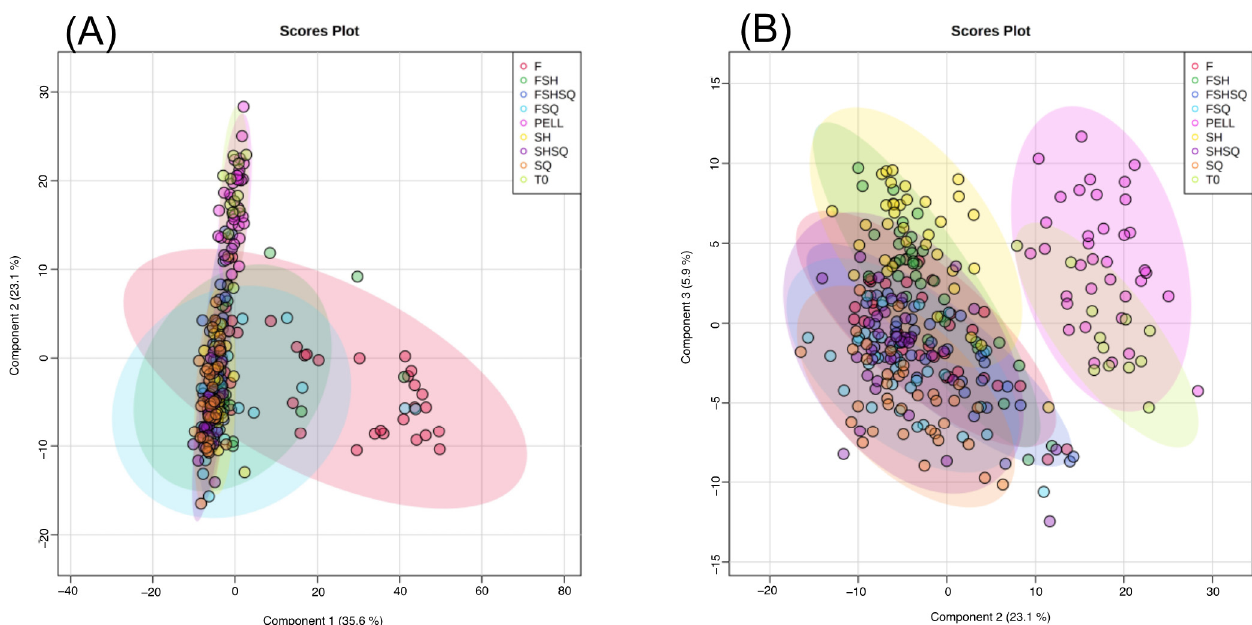
Figure 2. Supervised PLS-DA score plot from red drum liver tissue extracts for the 8 diets evaluated in this study and the conditioning diet (T0). ( A ) PC1/PC2 score plot. ( B ) PC2/PC3 score plot. The explained variances along the principal components are shown in brackets. Shaded areas represent the 95% confidence regions. PLS-DA score plot model validation (NC = 2; R 2 = 0.455; Q 2 = 0.430; 1000 permutations: p < 0.001).